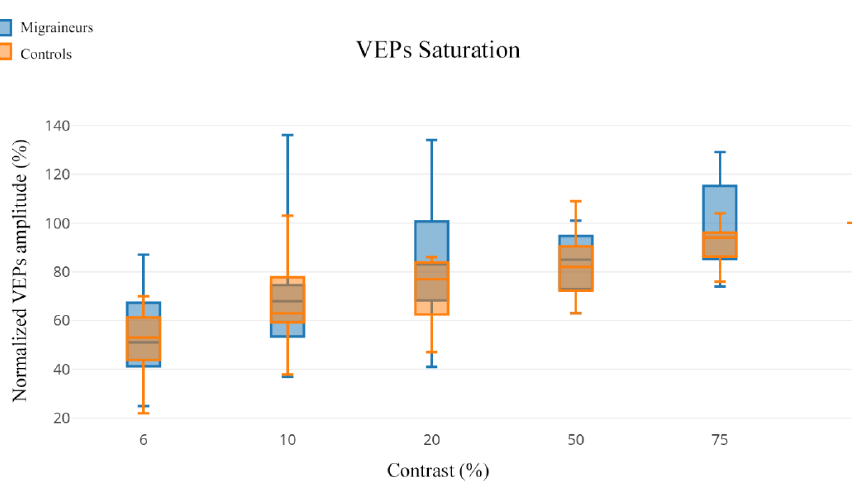
Figure 1. Graphic representation of normalized amplitude variations in response to contrast gain for both migraineurs and controls. The plot evidences a higher variability of visual evoked potentials (VEP) amplitude response in migraineurs, particularly at the contrast of 20%.